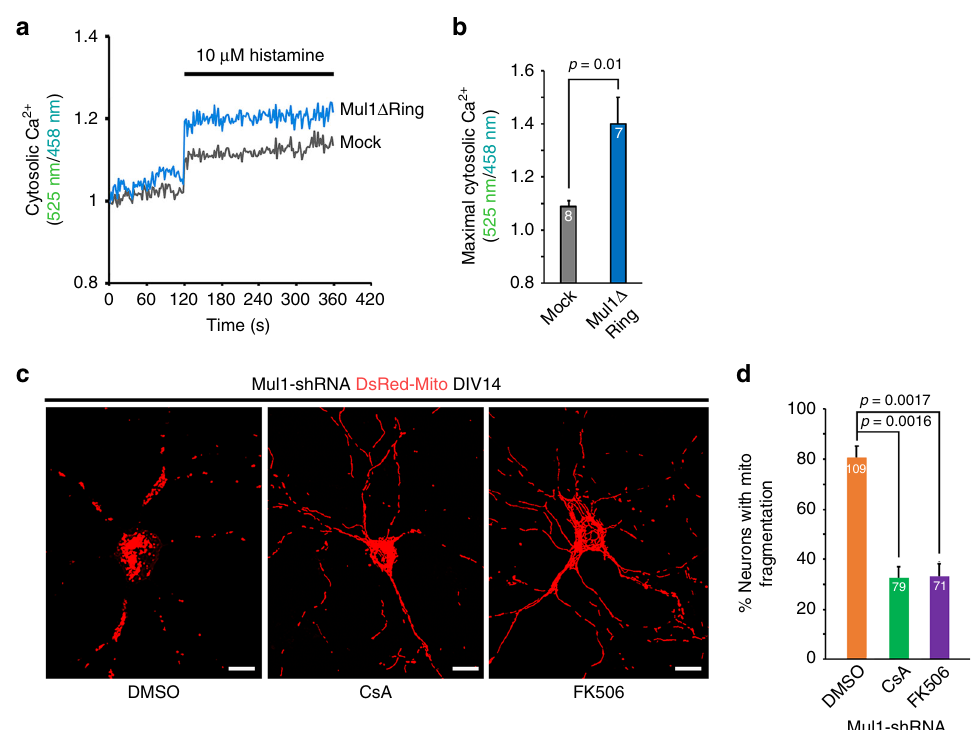
Fig. 8 Increased cytoplasmic Ca 2 + load induces mitochondrial fragmentation. a , b Representative traces and quantitative analysis of the average cytoplasmic Ca 2 + peak showing enhanced cytoplasmic Ca 2 + load in Mul1-de fi cient neurons. Cortical neurons were co-transfected at DIV7-8 with pcDNA- D3cpv and Flag or Flag-MUL1 Δ Ring, followed by live imaging at DIV12-13 just before mitochondrial fragmentation. The emission spectra of the ratiometric probe (525 nm/458nm) were obtained by exciting 405 nm following stimulation with 10 μ M histamine. Note that Mul1-de fi cient neurons display an increased cytoplasmic Ca 2 + peak ( p = 0.01) following histamine-induced Ca 2 + release from the ER. Data were analyzed from 2 to 3 live neurons per fi eld with 3 to 4 fi elds per experiment and the number of trials is indicated in the bars. c , d The role of calcineurin activity in mitochondrial fragmentation in Mul1-depleted neurons. Cortical neurons, co-transfected with DsRed-Mito and Mul1shRNA at DIV7-8, were treated with CsA (0.5 μ M) or FK506 (0.6 μ M) for 48 h starting at DIV12. Note that blocking calcineurin activity by CsA or FK506 abolishes mitochondrial fragmentation in Mul1-depleted neurons at DIV14. All data were analyzed from the total number of neurons indicated in the bars in three experiments and are expressed as mean ± s.e.m. Unpaired Student ’ s t -test ( b ) or Ordinary one-way ANOVA with Dunnett ’ s post hoc test ( d ). Scale Bars: 10 μ